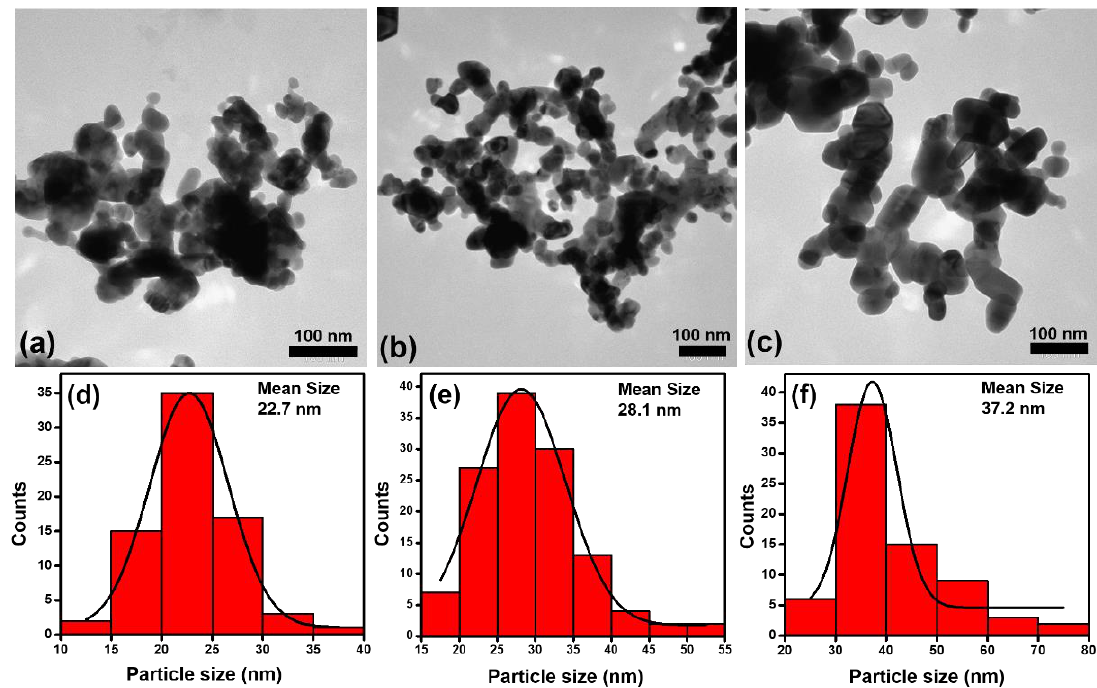
Figure 5. TEM images of Cu x Zn y O mixed metal oxide nanoparticles calcined at ( a ) 350 ◦ C, ( b ) 450 ◦ C, and ( c ) 550 ◦ C. Particle size distribution graph obtained from TEM images of ( d ) 350 ◦ C, ( e ) 450 ◦ C, and ( f ) 550 ◦ C.